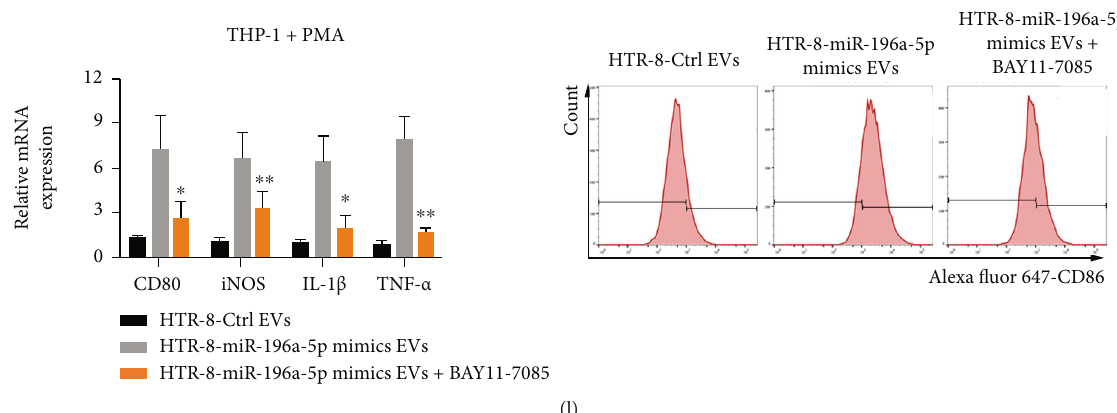
Figure 5: Trophoblast-derived EV miR-196a-5p promotes M1 polarization of macrophages via an I κ B α -mediated NF- κ B pathway. (a) Predicted miR-196a-5p binding sequence on the 3 ′ -UTR of I κ B α . (b) The e ff ects of overexpression or knockdown of miR-196a-5p on the luciferase activity of I κ B α reporter gene in 293T cells. (c) Luciferase activity of I κ B α reporter in 293T cells treated with EVs (25 μ g/ml) derived from